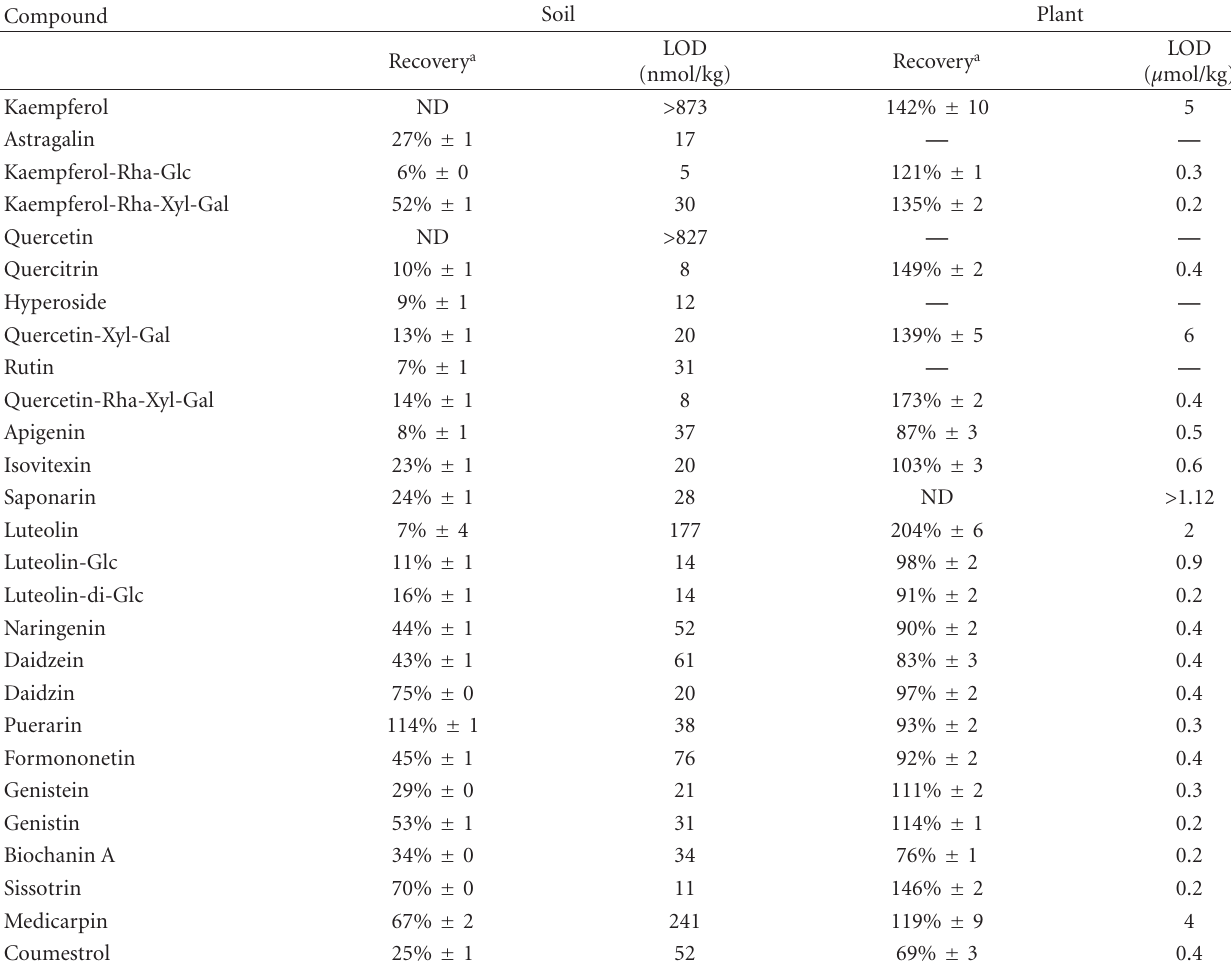
Table 4: Recovery (%) and detection limits (molar quantities per dry weight) of quantified compounds in plants and soil, respectively.